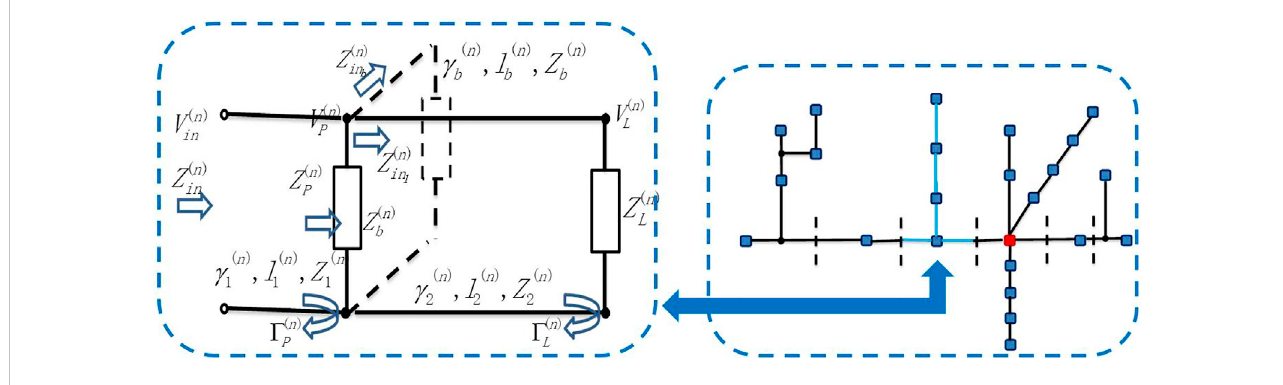
FIGURE 2 Typical network topology